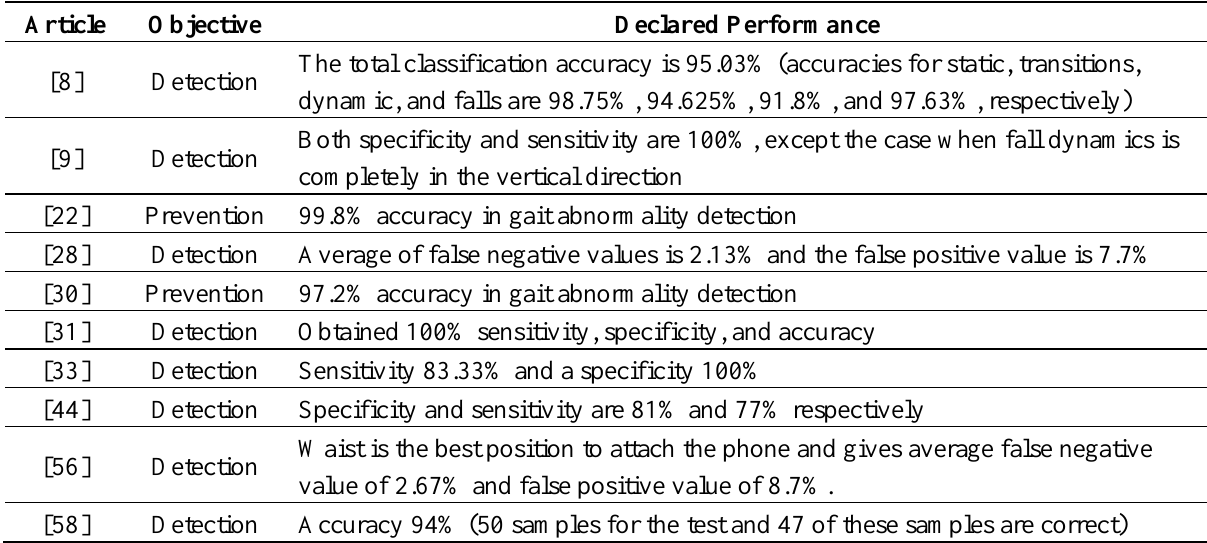
Table 5. Declared performances of the SP based fall detection and prevention